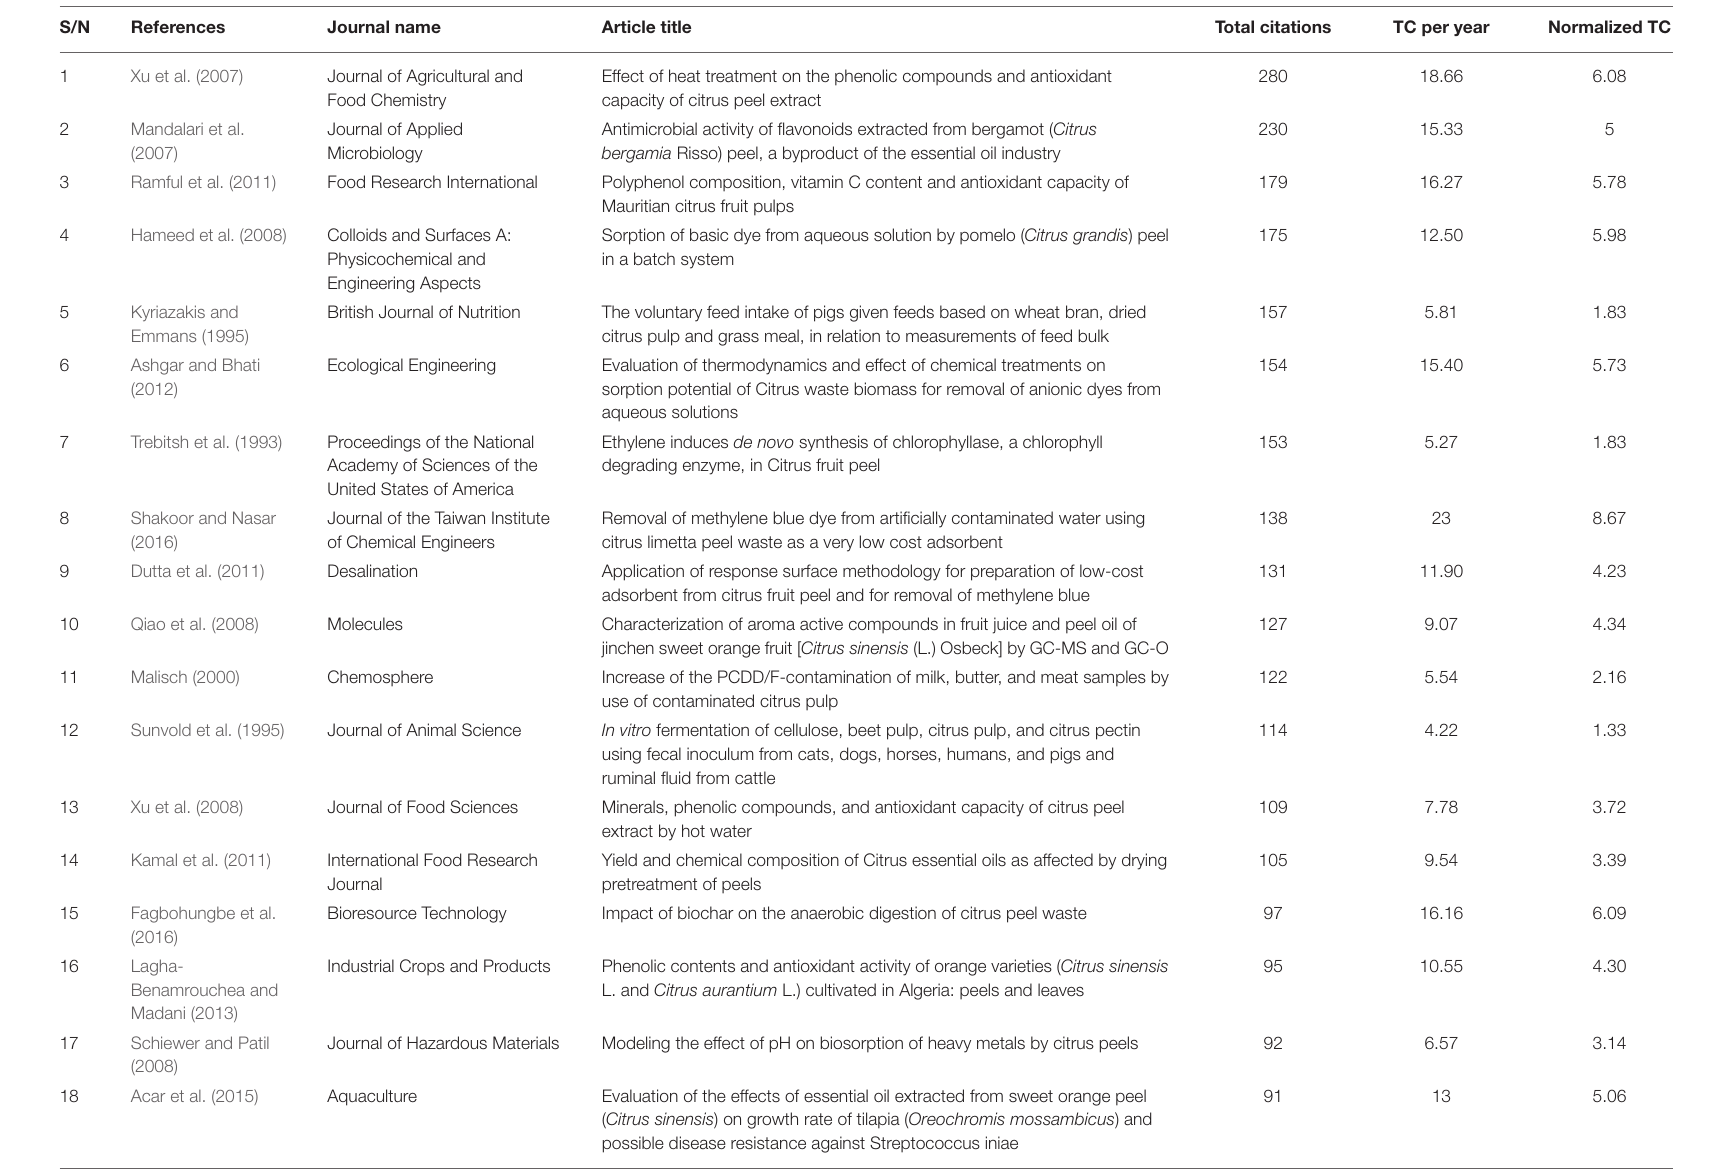
TABLE 6 | Top 20 most cited articles on citrus waste and animal feed research from 1961 to 2020.